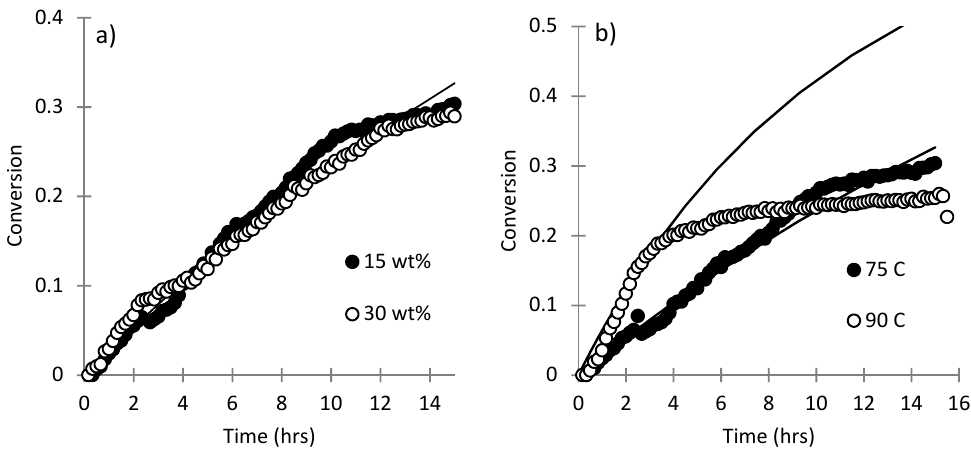
Figure 6. Fit of the homopolymerization SHMeMB model assuming no depropagation to monomer conversion profiles obtained at ( a ) 75 °C with 1 wt % V-86 at different monomer concentrations, and ( b ) at different temperatures with 1 wt % V-86 and 15 wt % monomer. Solid lines represent model output, with experimental results indicated by data points.